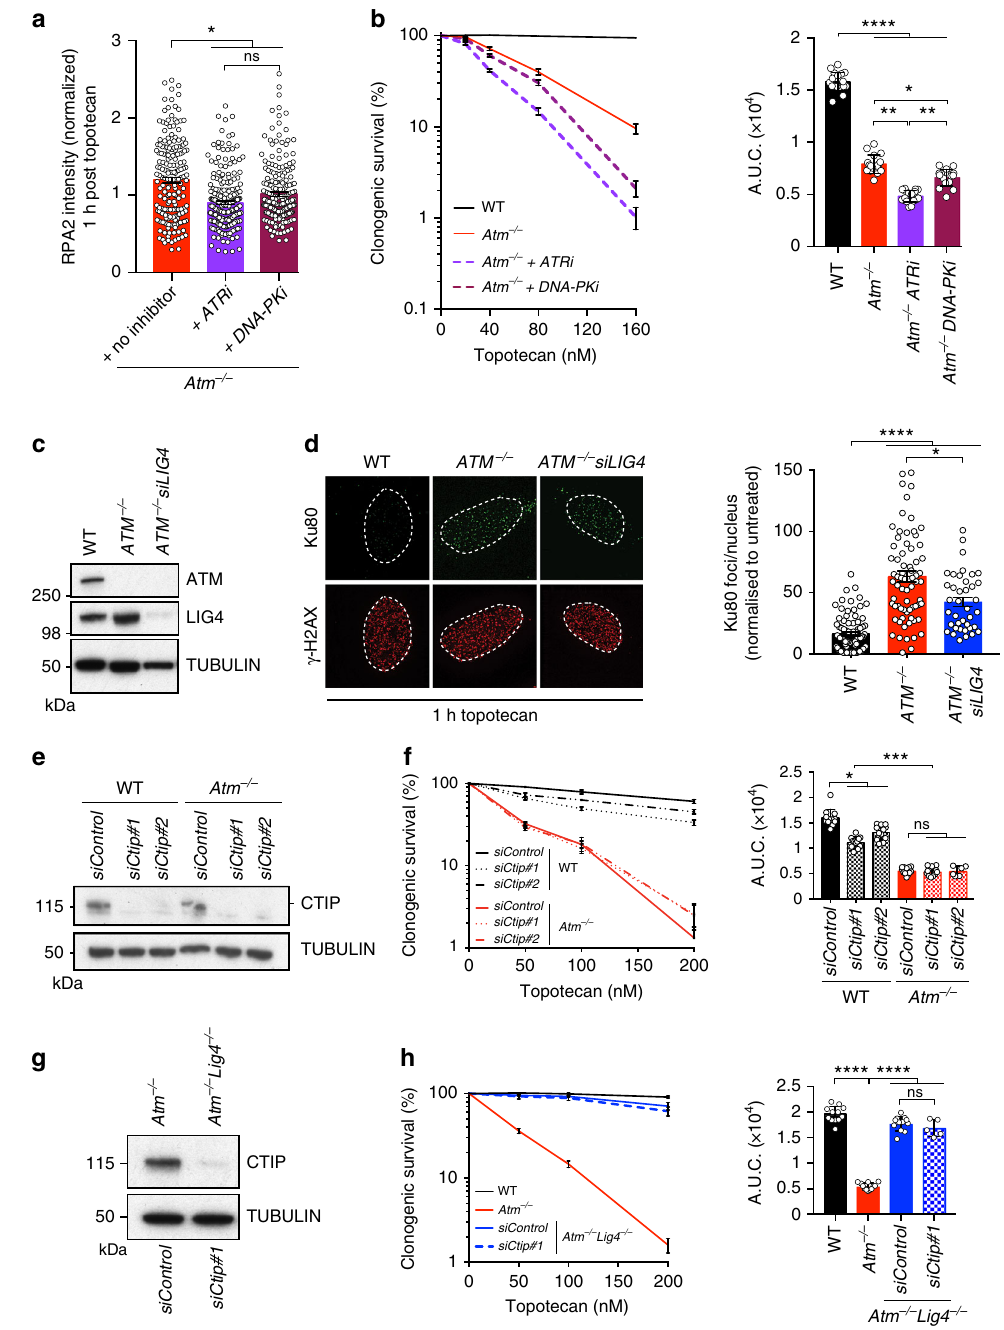
(Fig. 8a, b; for controls showing equivalent cell-cycle progression see Supplementary Figure 6b, c; for karyotypes and SCEs, see other fi ndings indicating that, although delayed, HRR of seDSBs